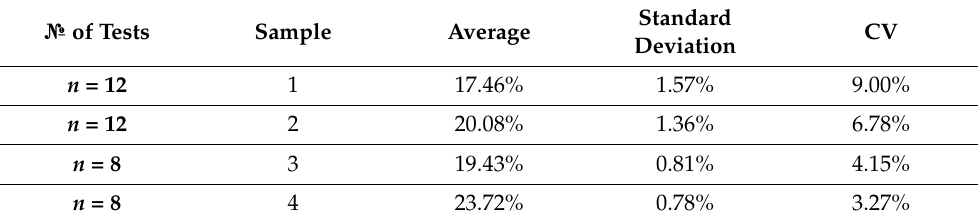
Table 2. Results for 1.00 g.